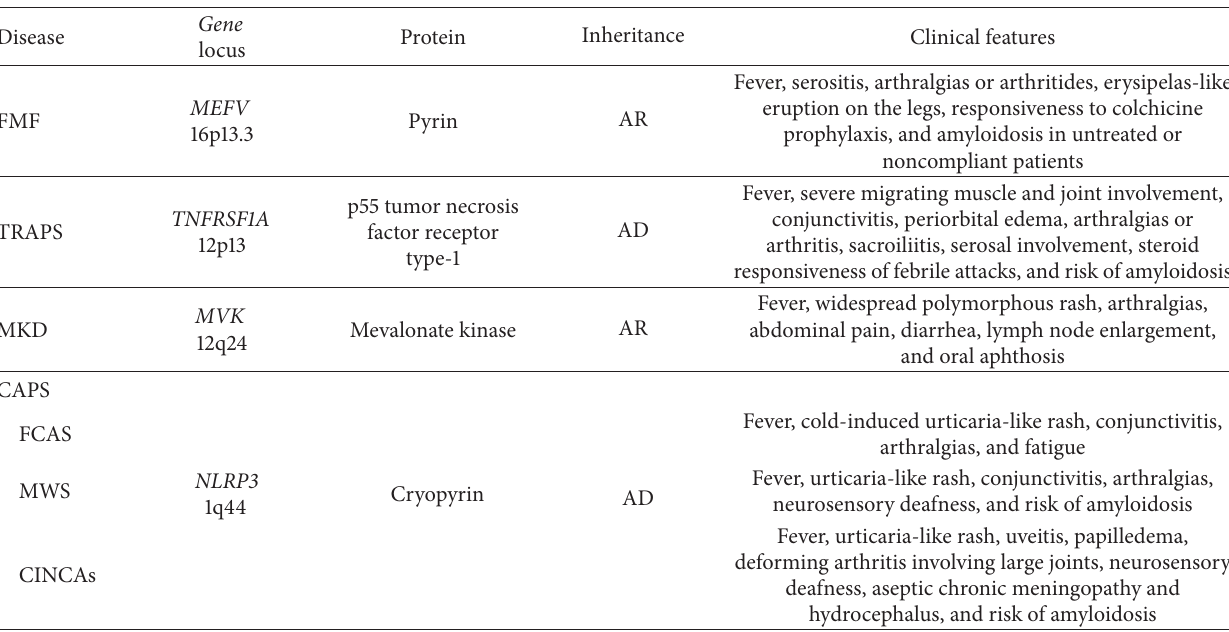
Table 2: List of the genetic and clinical features of the main hereditary autoinflammatory disorders.